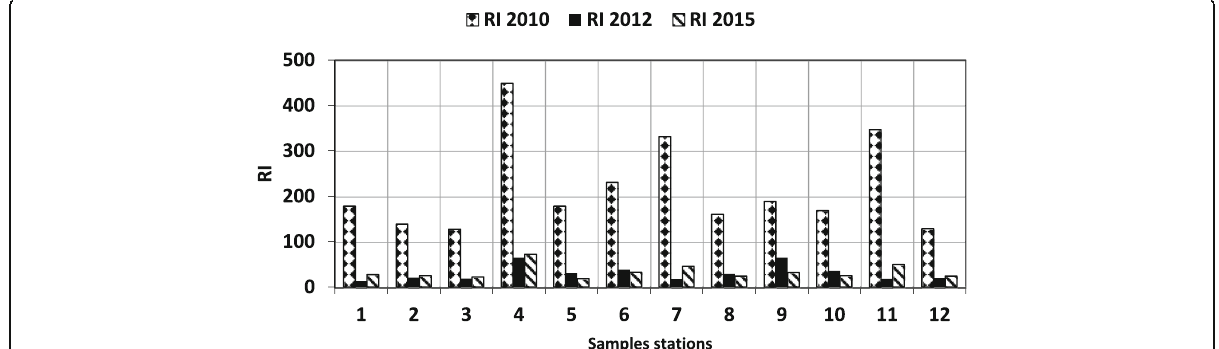
Fig. 5 RI variation in 3 years. a The potential ecological risk index (RI) was defined as the sum of the risk actors: RI = ∑ Er. B. b The results through different 3 years the degree of contamination in bottom